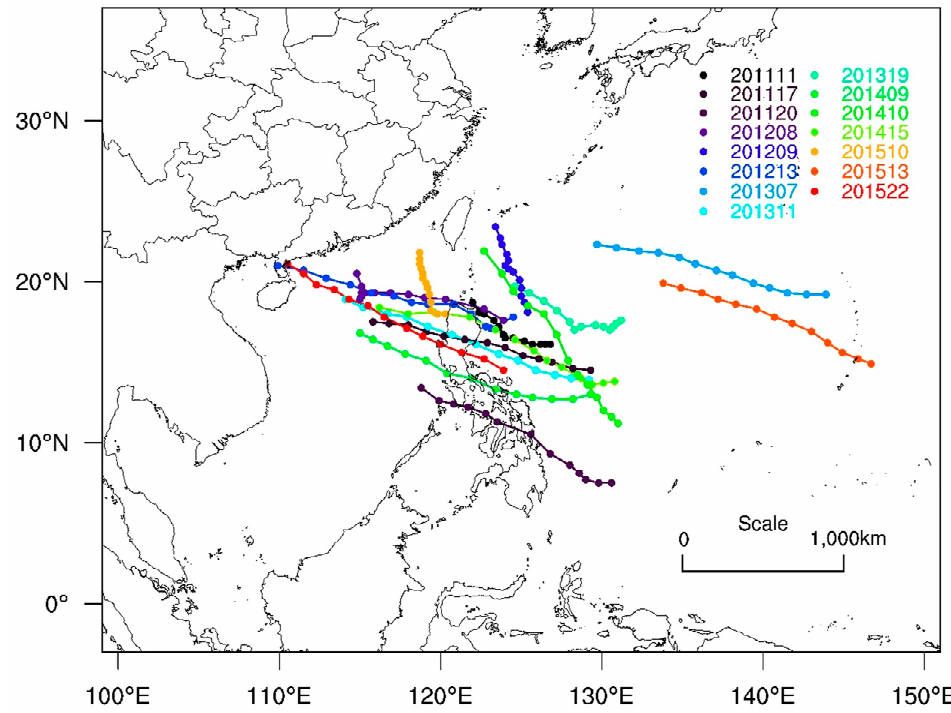
Figure 1. Three-day tracks of the 15 typhoons simulated over the Northwest Pacific Ocean. Table 1. Summary of the 15 simulated typhoon cases, including the typhoons’ Chinese number ID, names, and simulation periods *.